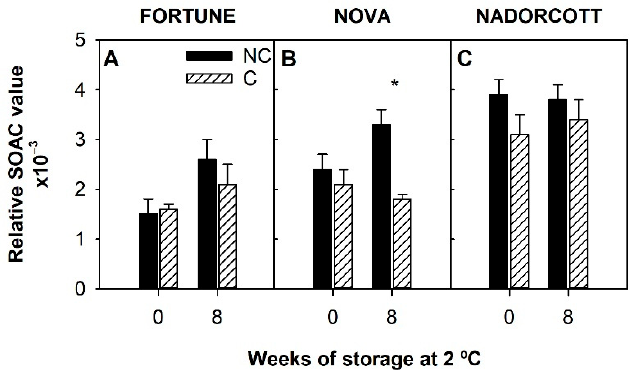
Figure 5. Relative SOAC value at harvest (0) and after 8 weeks of storage at 2 °C in the peel of non-covered (NC) and covered (C) fruit of Fortune ( A ), Nova ( B ), and Nadorcott ( C ). Asterisks indicate significant differences between NC and C fruit for each cultivar and sample date ( p ≤ 0.05, t- test).